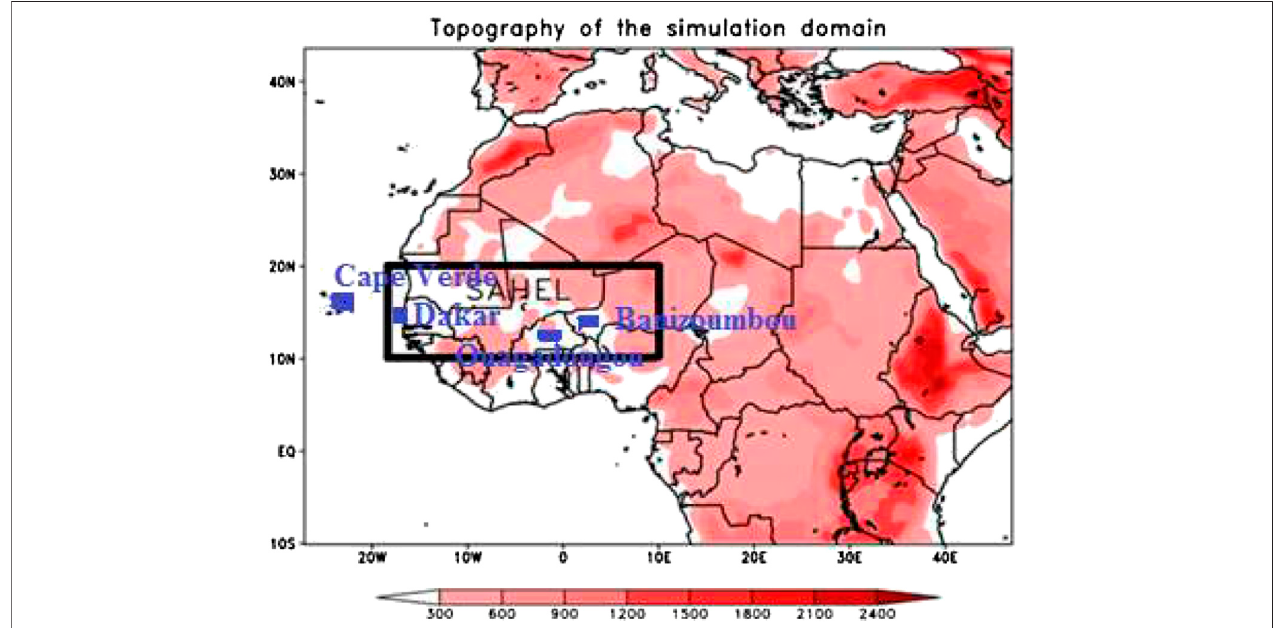
FIGURE 1 | Topography (m) of the simulation domain (West Africa) and the four AERONET observation sites. The interested area (the Sahel) in rectangle.